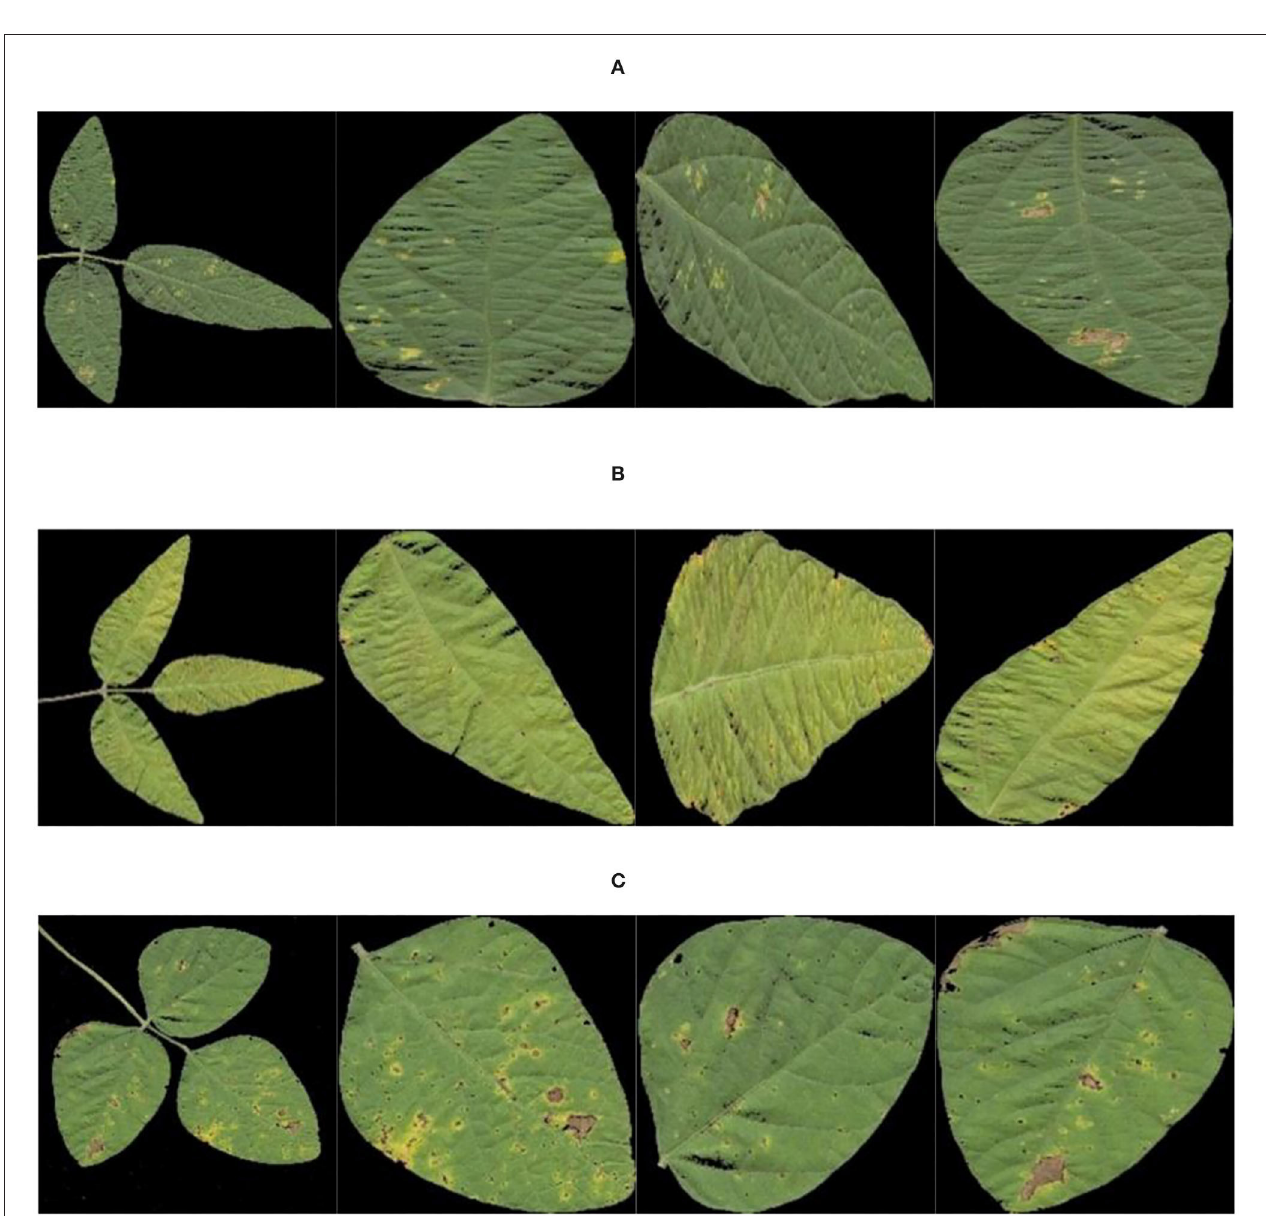
FIGURE 8 | Results of region labeling. (A) Soybean brown leaf spot; (B) soybean frogeye leaf spot; (C) soybean phyllosticta leaf spot.